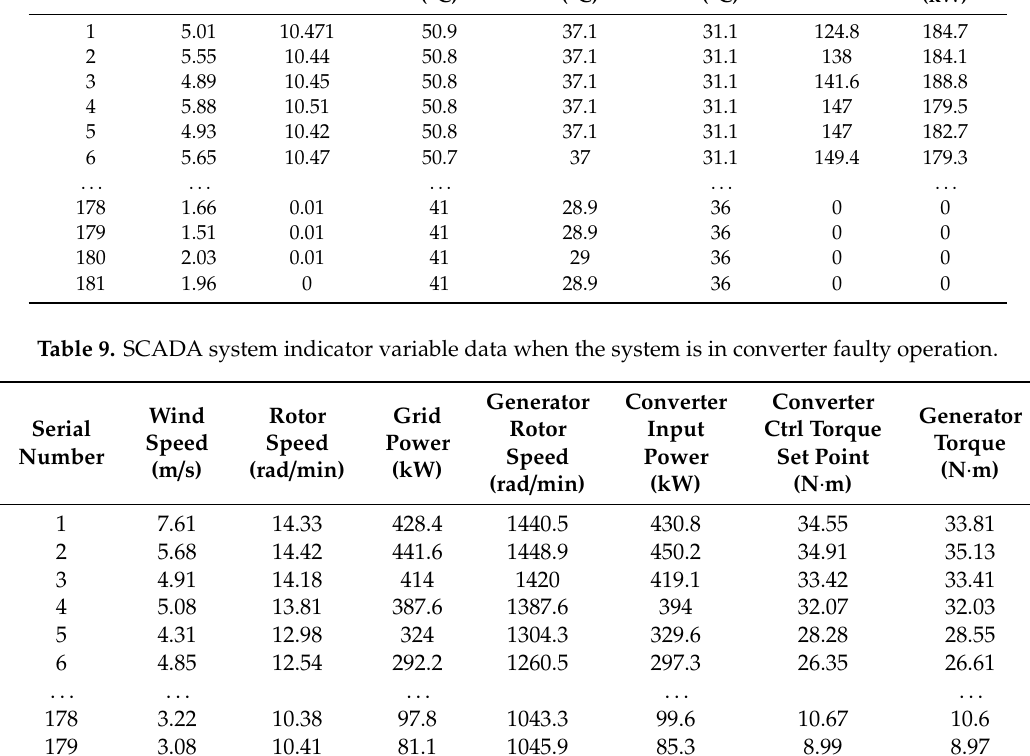
Table 8. SCADA system indicator variable data when the system is in generator faulty operation.